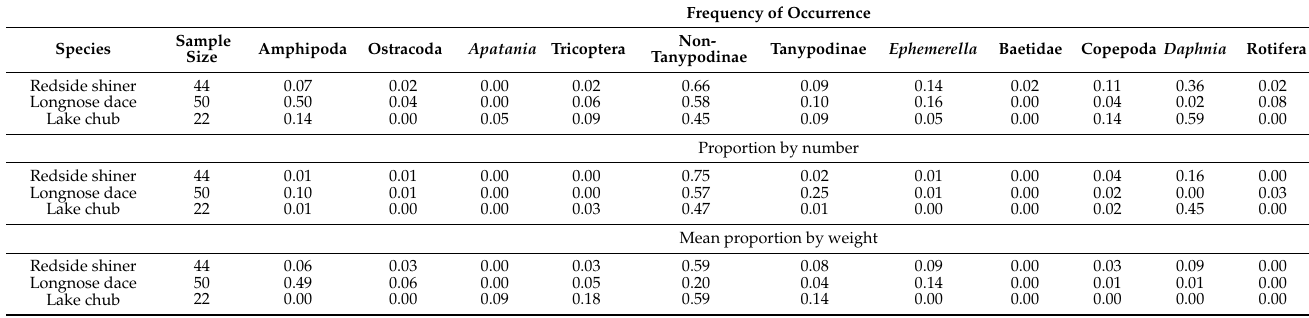
diet composition for all species (Table 1). Longnose dace had the highest frequency of occurrence for Amphipoda with 50% of the individuals having at least one amphipod in the diet. Chironomidae Non-tanypodinae were ≥ 0.47 of the diet composition for all species using proportion by number (Table 1). Redside shiner had the highest proportion by number for Chironomidae Non-tanypodinae of 0.75, and proportion by number was 0.01 for Amphipoda. Daphnia and Chironomidae Non-tanypodinae proportion by number was ≥ 0.45 for lake chub and 0.01 (a very low proportion by number) for Amphipoda (Table 1). Longnose dace had a proportion by number in Chironomidae Non-tanypodinae of 0.57, and proportion by number for Amphipoda was 0.10 (Table 1). For mean proportion by weight, Chironomidae Non-tanypodinae comprised 0.59 of diet for redside shiner and lake chub. Amphipoda comprised 0.49 of diet by mean proportion by weight for longnose dace (Table 1). The two nonnative species, redside shiner and lake chub, had the greatest diet overlap (Table 2), which can be attributed to their high reliance on Chironomidae Non-tanypodinae and Daphnia (Table 1). However, no overlap was observed between the native and nonnative minnows (Table 2) because of the high reliance on Amphipoda by longnose dace (Table 1). Table 1. Diet contents for redside shiner, longnose dace, and lake chub collected in the littoral zone of Yellowstone Lake, Yellowstone National Park, USA during the ice-free season of 2020 by frequency of occurrence, proportion by number, and mean proportion by weight. Chironomidae include non-tanypodinae and tanypodinae diet items.